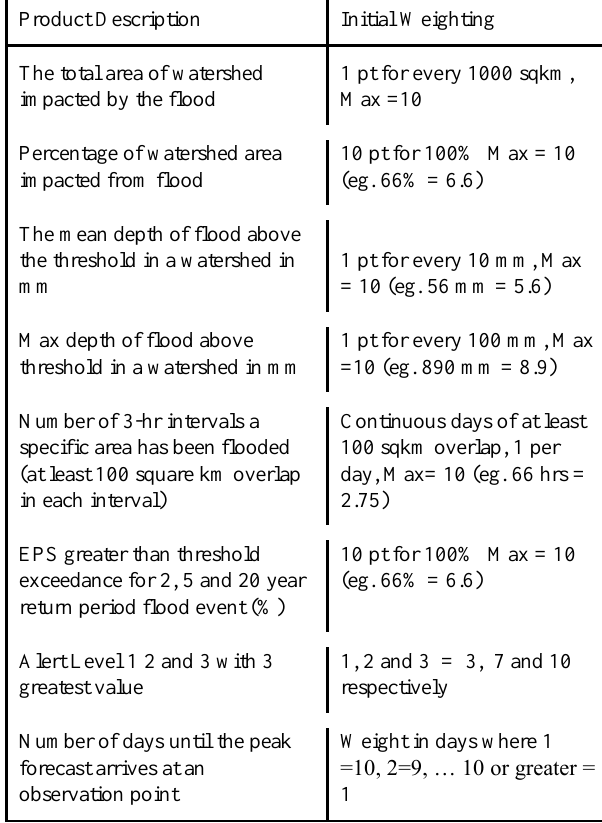
Table.1 Weighting scheme for hazard